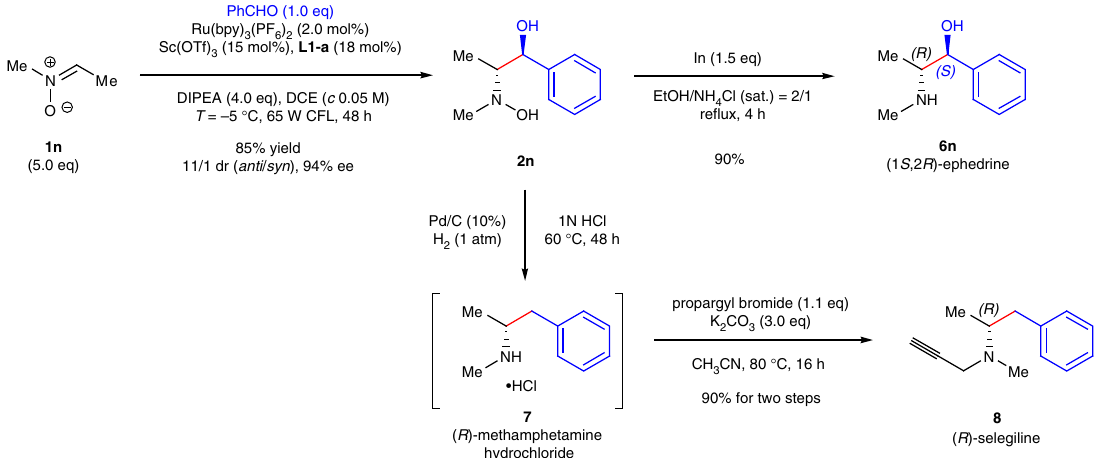
Fig. 4 Concise synthesis of (+)-ephedrine 6n and ( − )-selegiline 8. A concise two-step synthesis of (1 S ,2- R )-(+)-ephedrine 6n and an ef fi cient three-step preparation of ( R )-( − )-selegiline 8 have been achieved both with 70% overall yield and